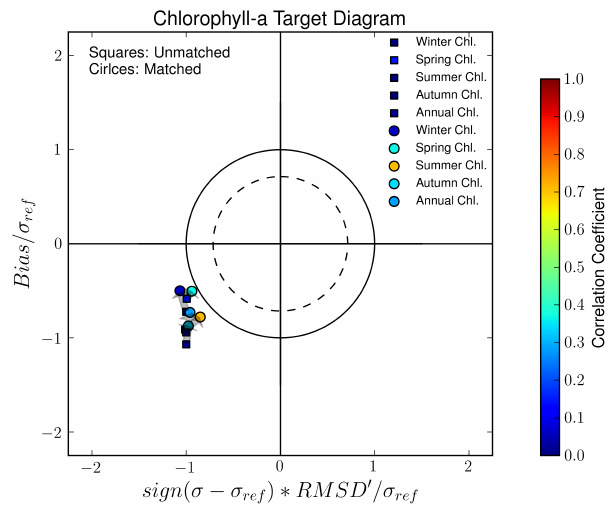
Fig. 23. Target diagram showing the impact of the transition from Fig.23. Targetdiagramshowingtheimpactofthetransitionfromtheunmatched tothematchedmethods on chlorophyll-a. the unmatched to the matched methods on chlorophyll a